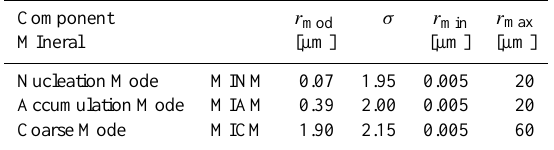
Table 1. Microphysical properties of mineral